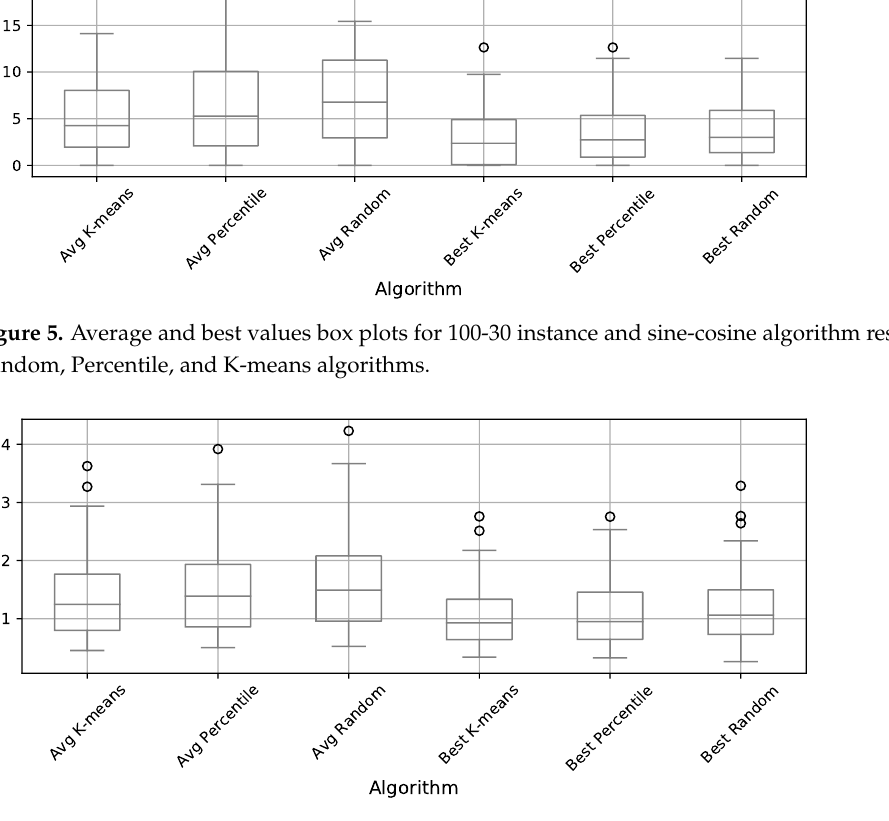
Figure 6. Average and best values box plots for 500-30-30 instance and cuckoo search algorithm results of Random, Percentile, and k-means